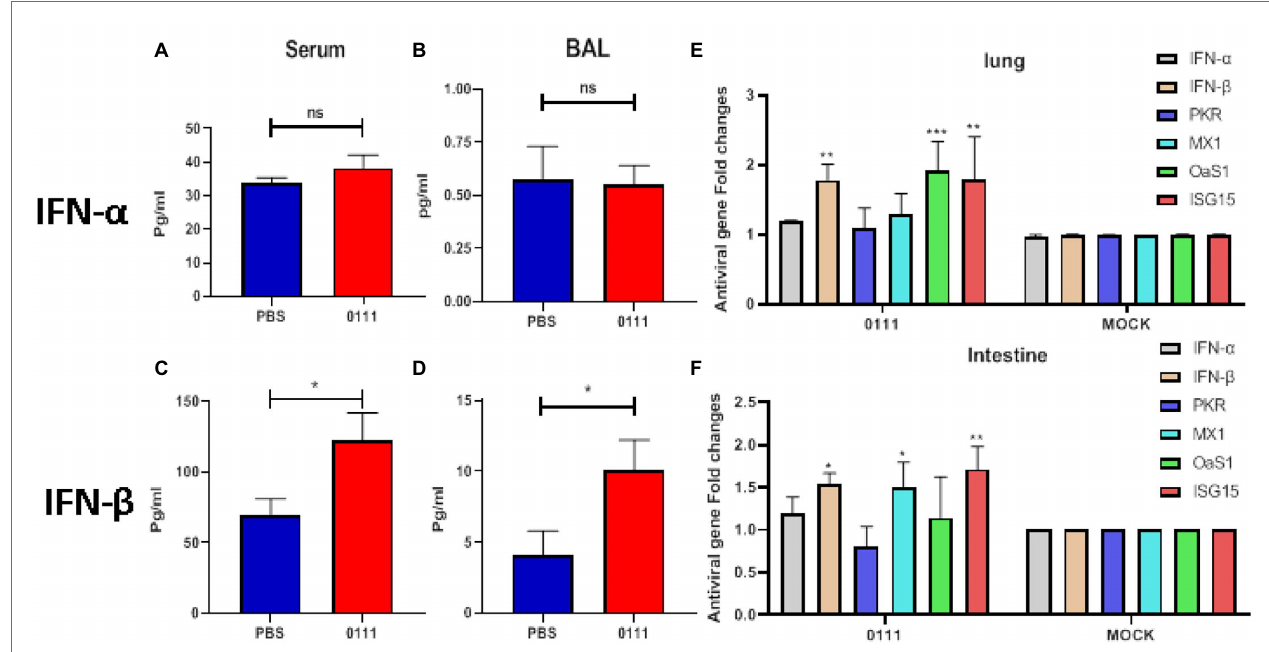
FIGURE 6 | Pretreatment of C57BL/6 mice with L. plantarum 0111 increased the expression of type I interferon in serum and bronchoalveolar lavage fluid (BALF) and increased the transcriptional levels of IFN- β and ISGs in the intestine and lungs. C57BL/6 mice ( n = 5/group) were euthanized 7 days after the continuous oral administration of L. plantarum 0111 (1 × 10 8 CFU/200 μ l/mouse), and IFN- α and IFN- β expression in serum and bronchoalveolar lavage fluid (BALF) was measured. (A)